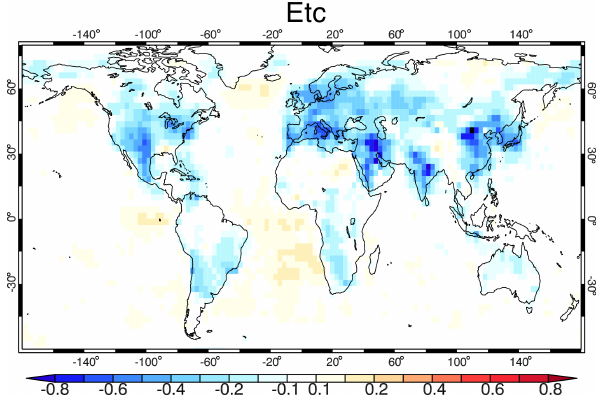
Figure 14. Global distribution of the annual mean correction factor for the emission diurnal variability (Etc) for the period